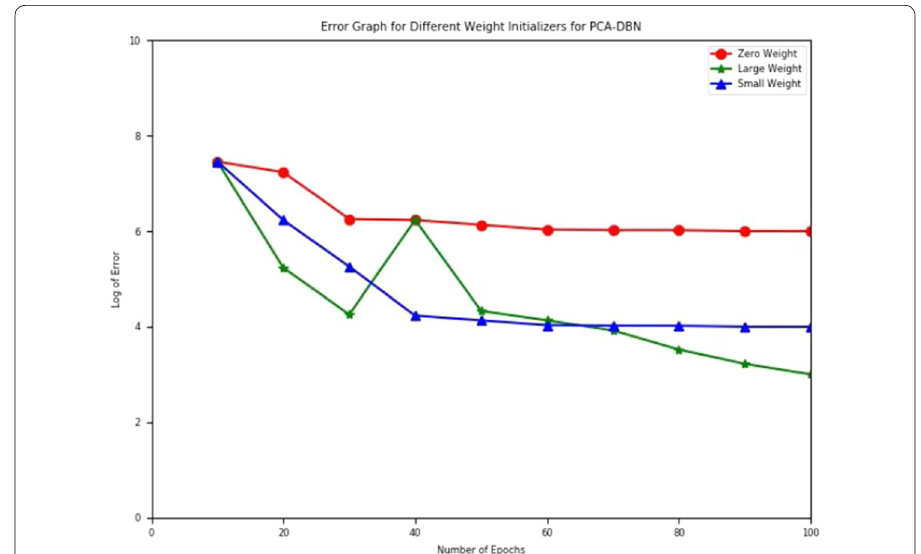
Fig. 8 Error graph for different number of layers for PCA-DBN